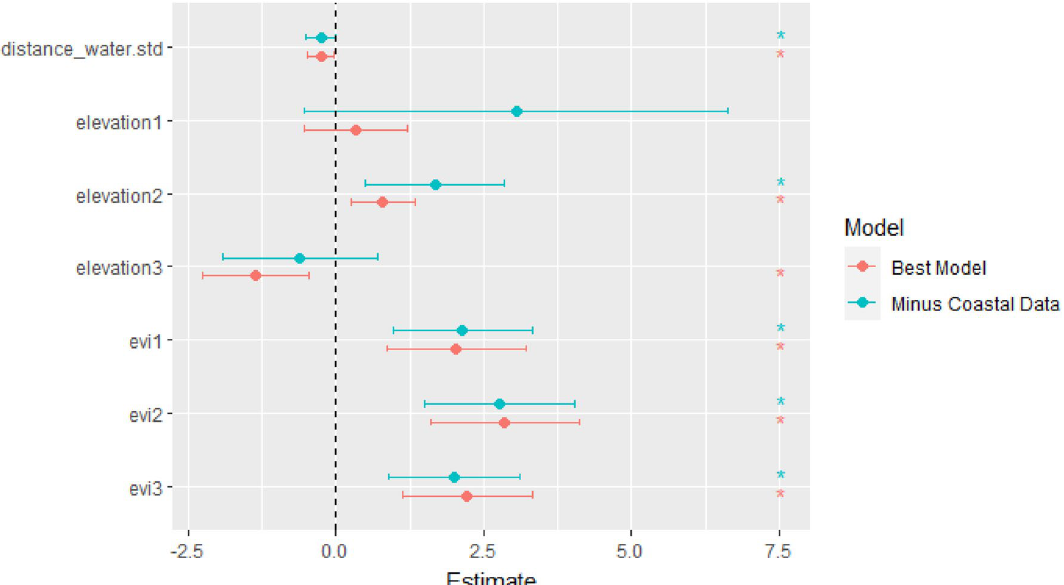
Figure 4. Geographical cross-validation tests for spatial model robustness. The figure shows the magnitude and direction of the fixed effects for the final model and the holdout model to test whether the model was robust following the exclusion of a spatially distinct block of